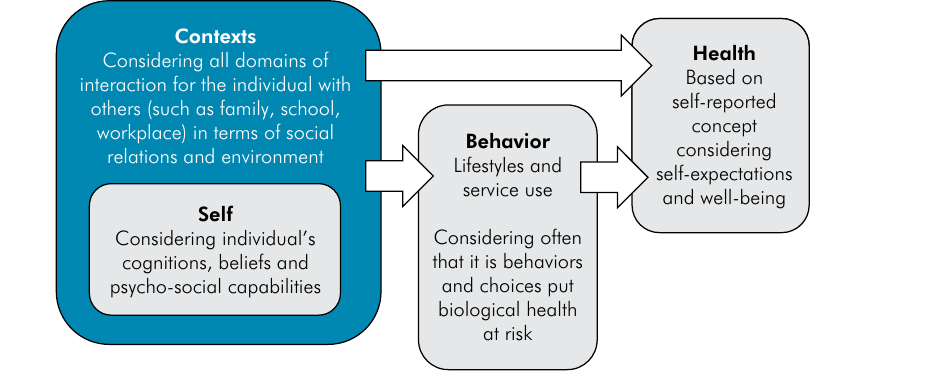
Figure 4. How education affects an individual’s life in all contexts and levels, including lifestyles that can positively or negatively influence health. Adapted from Feinstein et al.